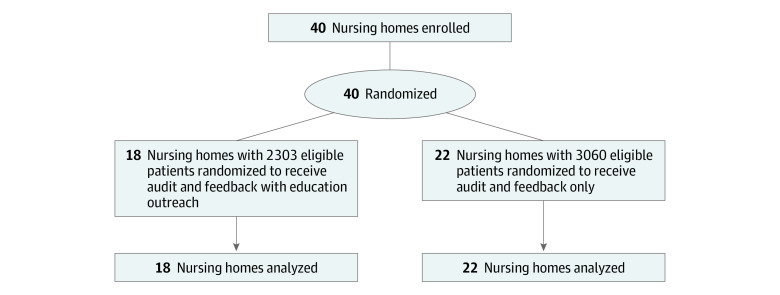
Study Flow Diagram for Cluster Randomized Trial